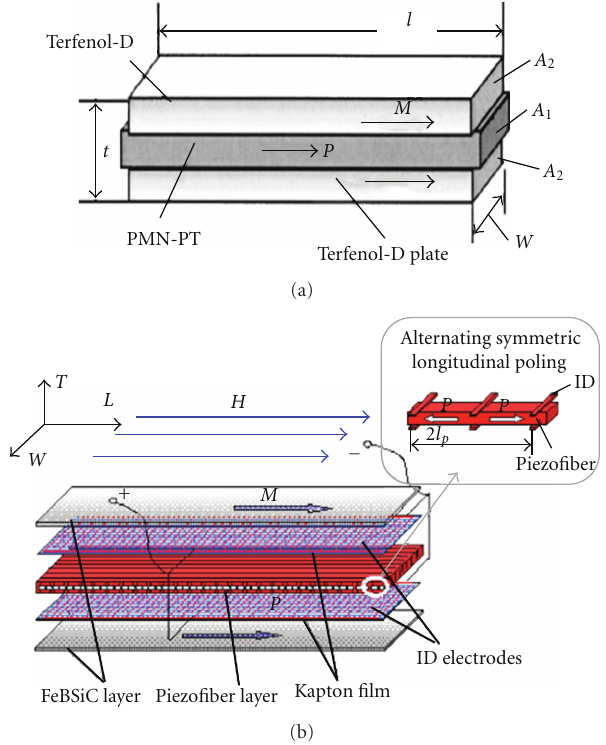
Figure 2: Schematic diagram of laminated composite (a) Terfenol- D sandwich structure with PMN-PT in the middle and (b) Magnetic FeBSiC top and Bottom layer with intermediate layer as piezoelectric fiber [42,